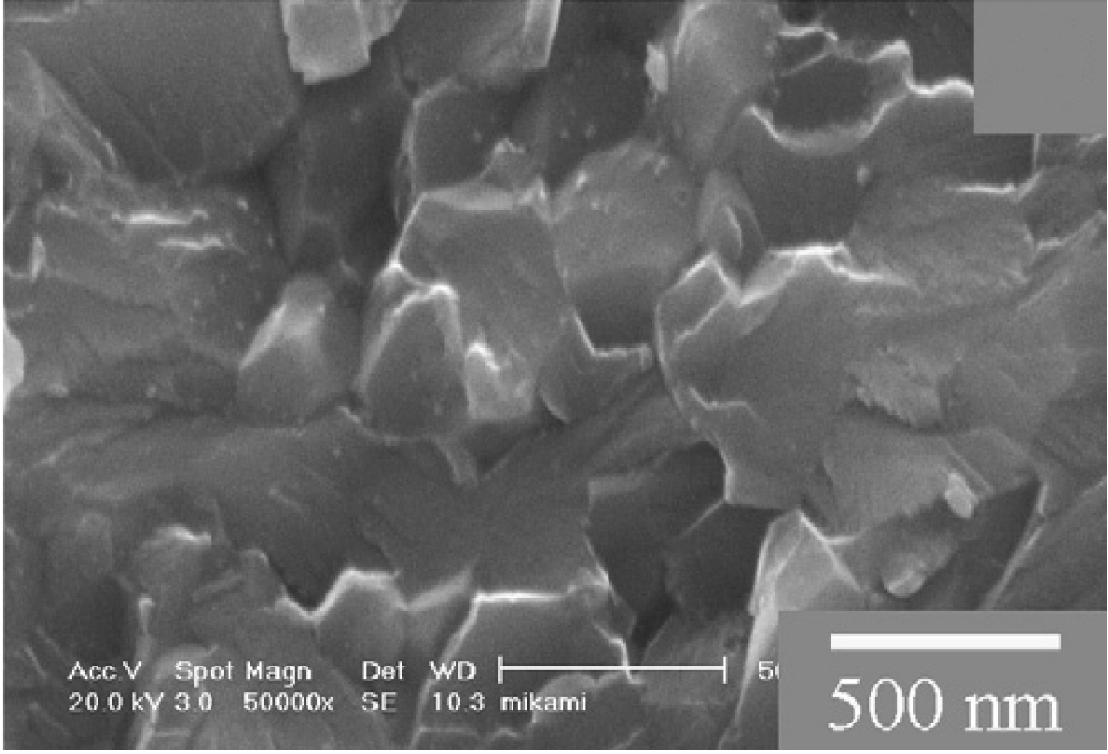
Figure 1. Scanning electron microscope image of mechanically alloyed and sintered (1000 °C) Fe 2 VAl 0.9 Si 0.1 . Reproduced from [23], with copyright permission from Elsevier,